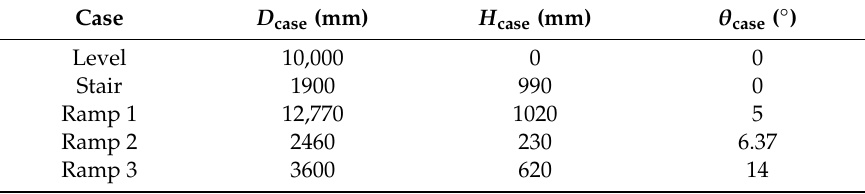
Figure 21. Terrains used for the tests (( a ) level ground, ( b )stair, ( c )ramp). The shoes in the figure indicate the start and end positions of the subject. The height of each step ( h step ) of the stairs is 165 mm. Table 4. Dimensions of the terrains for evaluating the performance of the developed Table 3. Demographic characteristics of the subjects